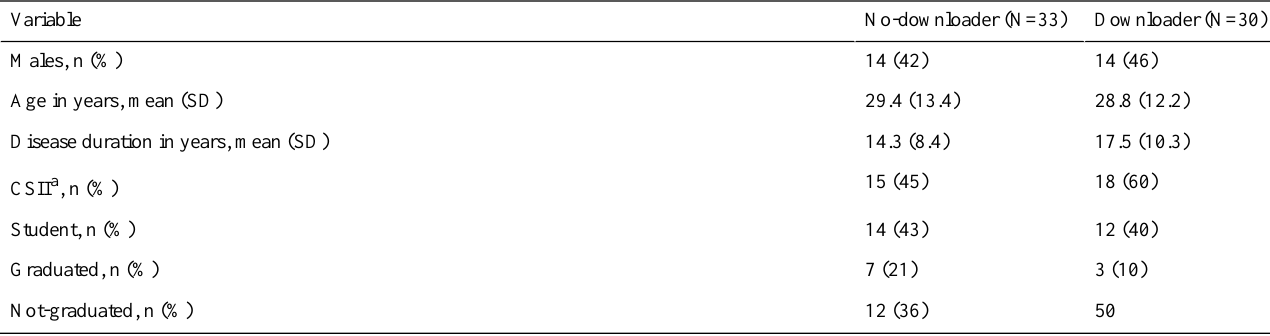
Table 1. Characteristics of subjects enrolled in the study and grouped as No-downloader (NDL) and Downloader